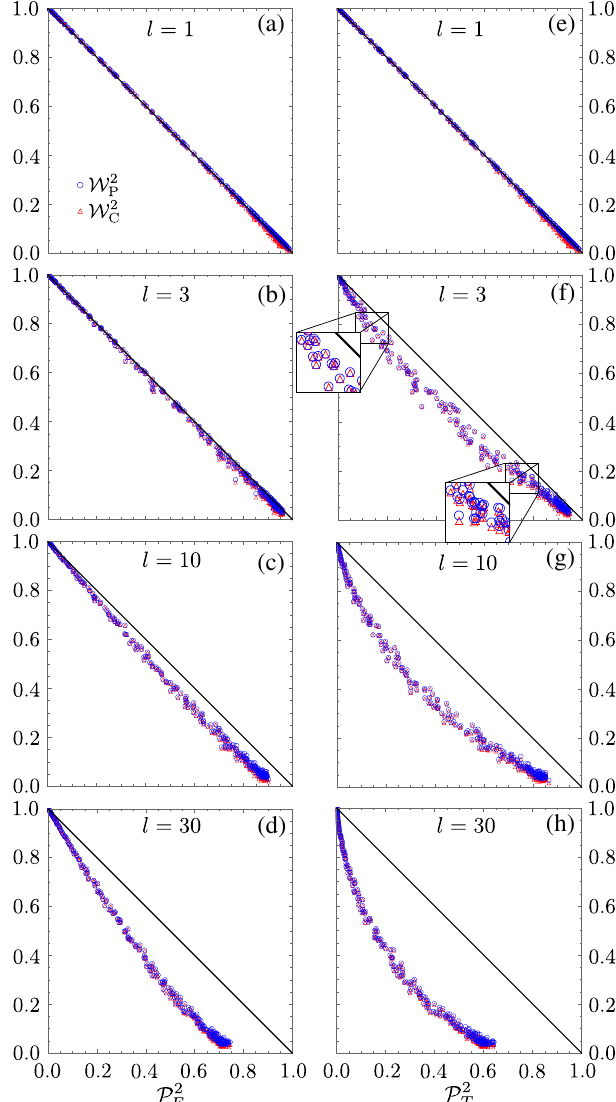
FIG. 4. Complementarity relations for 300 randomly generated states of three partially distinguishable particles, with l referring to the number of mixed internal states (see main text for details). Panels (a) – (d) show the wave character measures W 2 P (blue circles) and W 2 C (red triangles) plotted against the particle character quantifier P 2 F , while in panels (e) – (h), they are plotted against P 2 T . In all panels, the solid black line corresponds to the upper bound according to Eq.